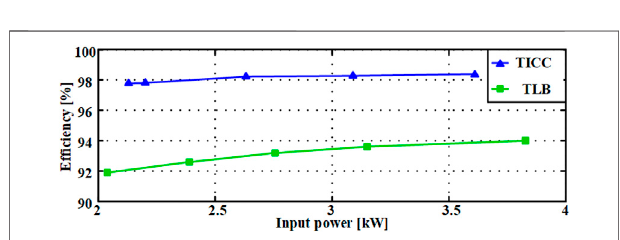
FIGURE 20 | Measured ef fi ciencies of the three-level boost converter and TICC converter under the same input voltage.